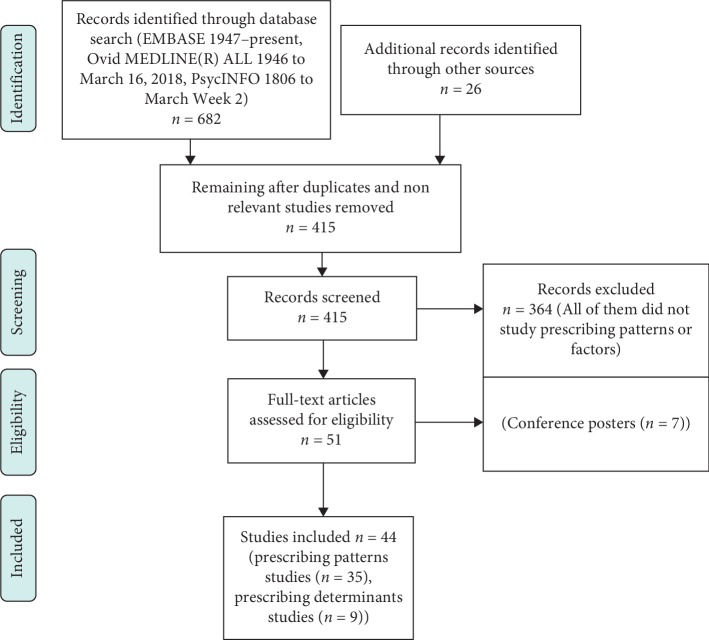
PRISMA flow chart for systematic research of prescribing patterns and determinants study.